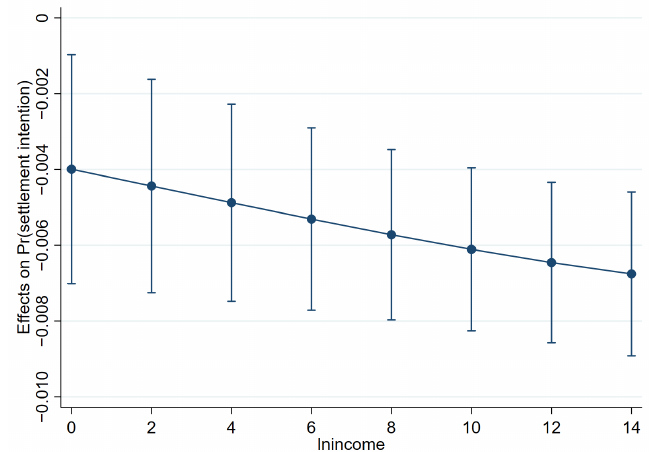
Figure A2. The average marginal effect of AQI at different levels of education.